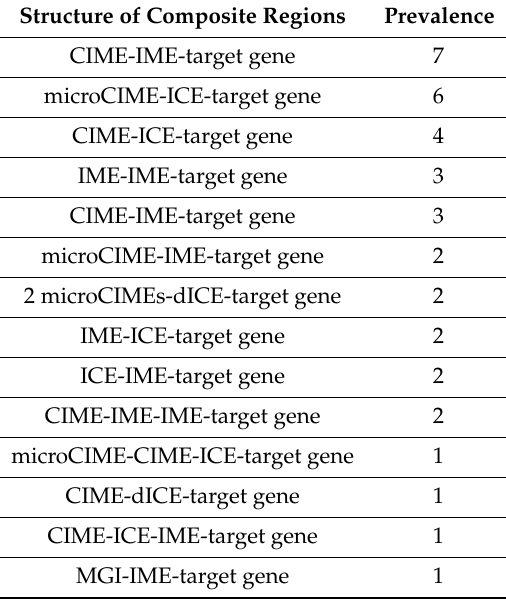
Table 2. Composite structures resulting from tandem